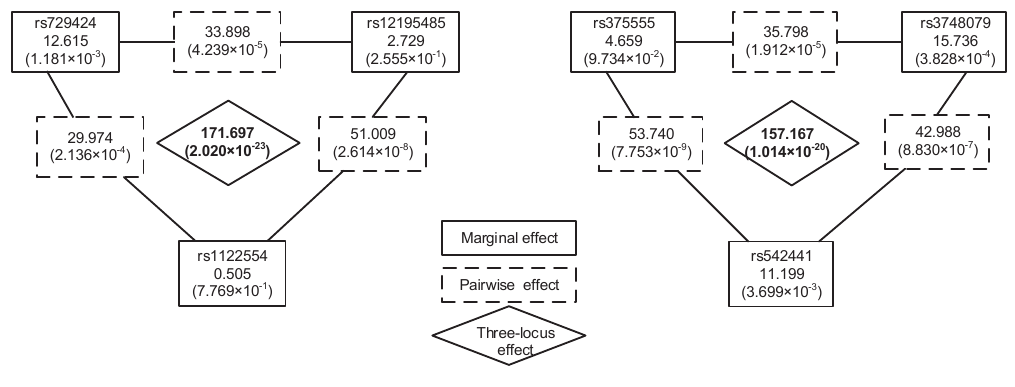
Figure 2. Two significant three-locus interactions identified by HiSeeker in the WTCCC CD data. A solid rectangle is an SNP with its name and marginal effect. A dashed rectangle represents the pairwise interaction effect of two SNPs. The diamond represents three-locus interaction effect. The marginal effect, pairwise effect and three-locus effect are evaluated by the chi-squared test. Values in brackets below the chi-squared statistics are the corresponding p -values. The Bonferroni-corrected significance levels for single-locus, two-locus and three-locus test are 1.181 × 10 − 7 , 5.582 × 10 − 13 , and 3.957 × 10 − 17 , respectively.